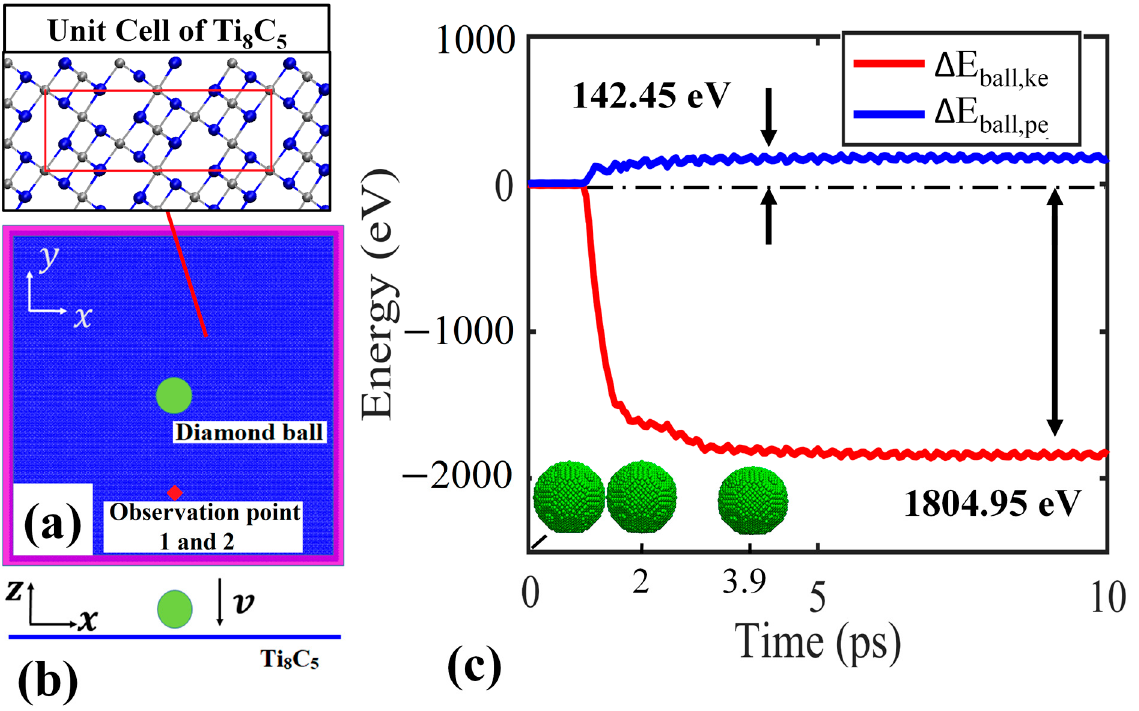
Figure 1. Impact simulation setup for the Ti 8 C 5 model, (010) with the plane of the Ti 8 C 5 facing the projectile. ( a ) Top view of the schematic setup. Insert shows the unit cell thickness of the (001) plane Ti 8 C 5 , and atoms labelled in silver and bule are carbon and titanium, respectively; ( b ) Side view of the schematic setup; the thickness of the model is equal to the thickness of the Ti 8 C 5 unit cell; ( c ) Energy change in projectile as a function of time for impact velocity of 2 km/s. ∆ E ball,ke and ∆ E ball,pe represent the kinetic and potential energy change of the projectile, respectively. The green balls represent the diamond projectile at a simulation time of 0, 2 and 3.9 ps. Significant deformation is not observed in the projectile during the impact process.